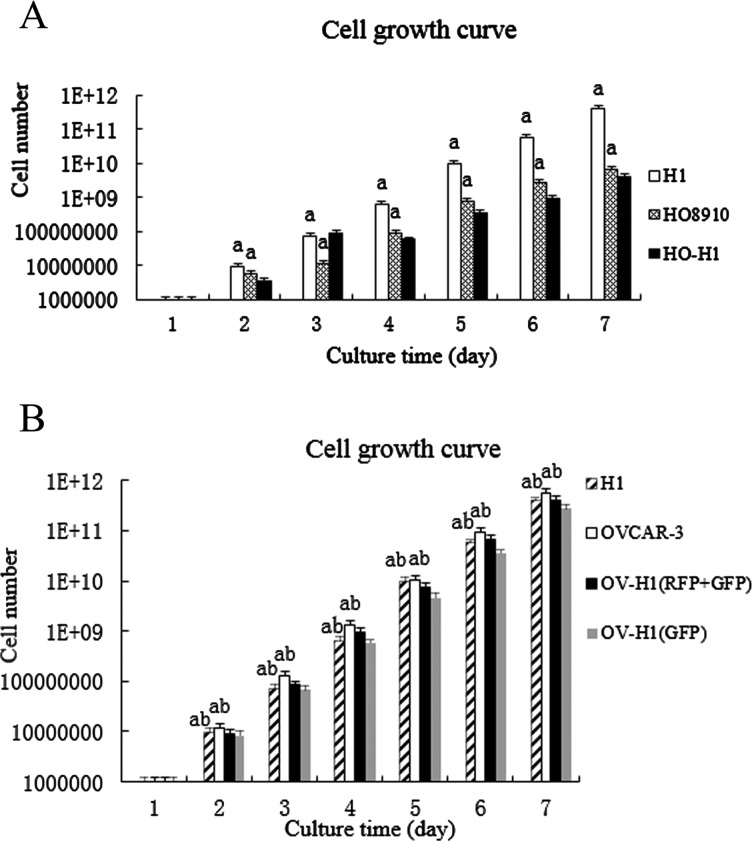
Growth curves of hybrid cells after fusion(A) The growth curve of hybrid cells after fusion of H1 and HO8910 cells. (B) The growth curve of hybrid cells after fusion of H1 and OVCAR-3 cells. Note: a, compared with the other cells, P< 0.05. b, compared with the hESCs and OVCRA-3 ovarian cancer cells, P>0.05.